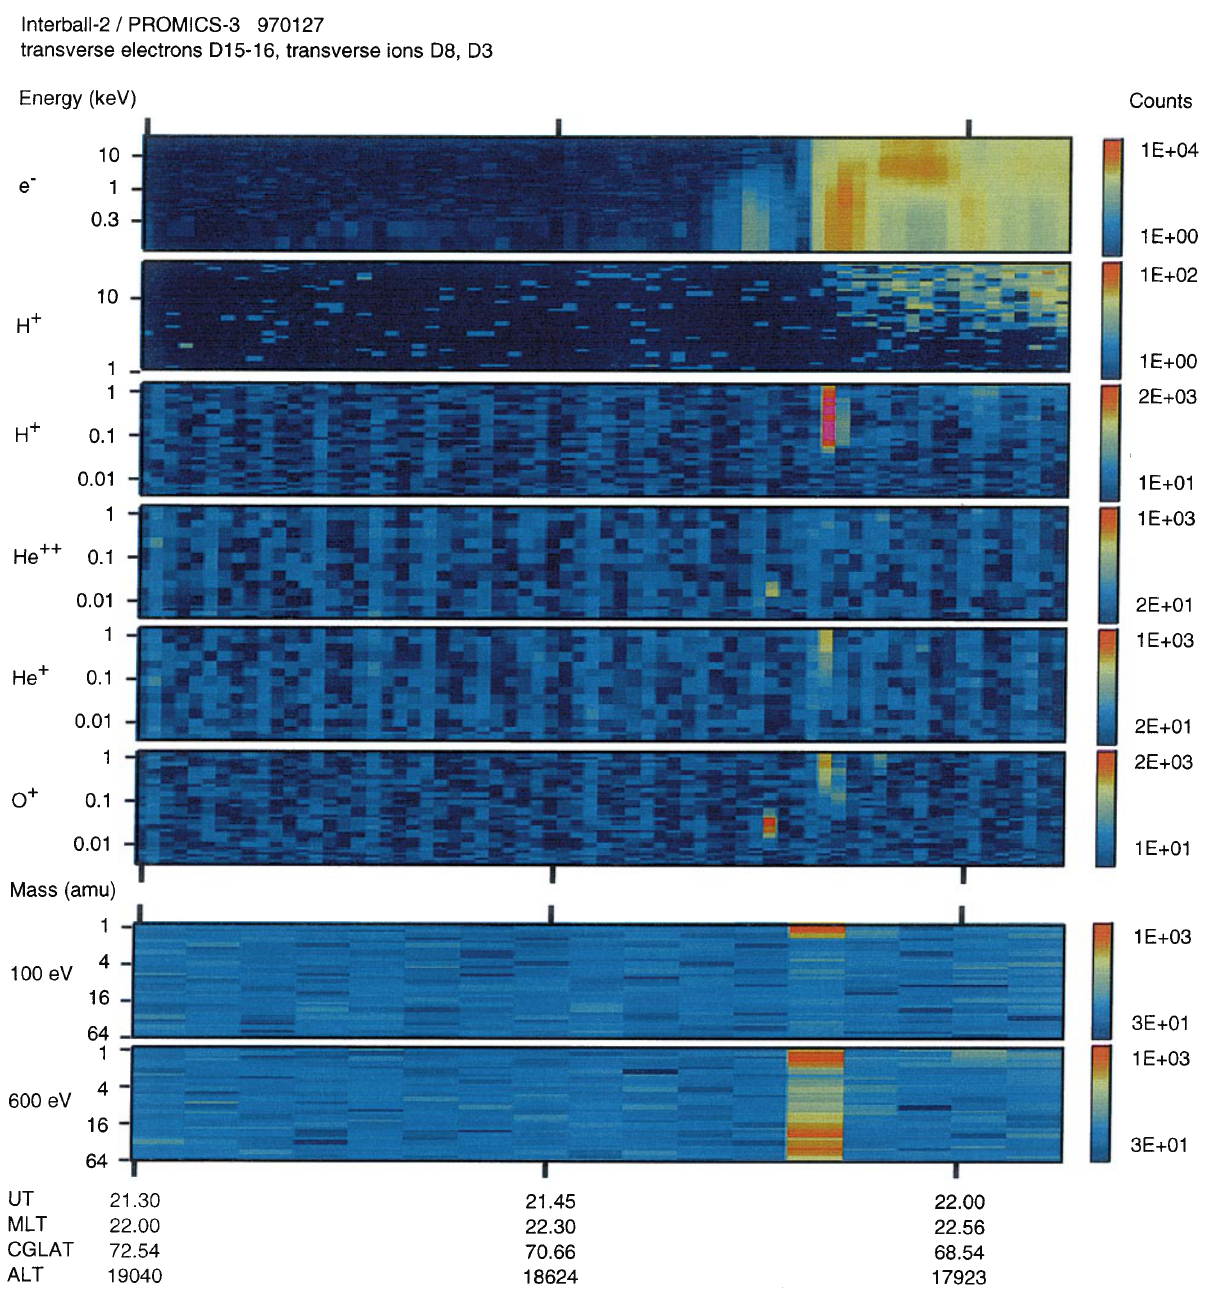
Fig. 9. Spectrogram from January 27, 1997. The six upper panels are energy spectrograms of electrons and di(cid:128)erent ion species, the two lower panels mass spectrograms at two di(cid:128)erent energy levels. Upward moving molecular ions were detected at